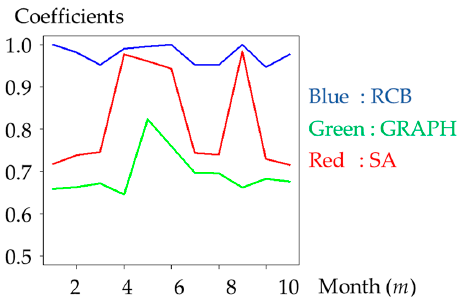
Figure 4. Jaccard’s similarity coefficients in each month. Large coefficients for RCB suggest that shapes of the RCB clusters are similar across months, while the small coefficients for GRAPH suggest that the opposite is true for the GRAPH clusters.